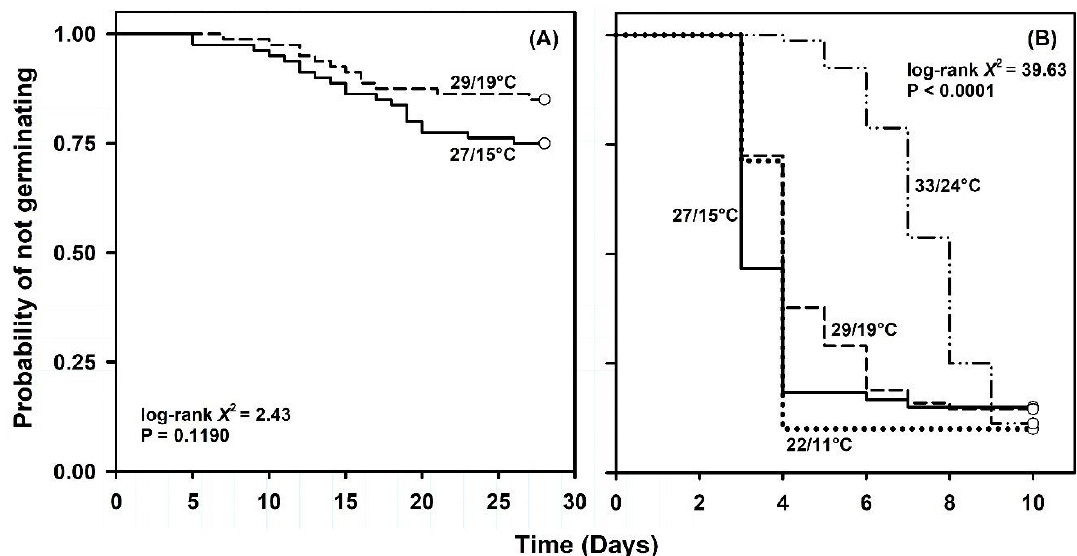
Figure 2. Kaplan–Meier estimates of survivor functions for Linum arenicola seeds exposed to ( A ) alternating temperatures that simulate the average maximum and minimum temperatures experienced throughout Florida during the winter (22/11 °C), early spring or late fall (27/15 °C), summer (33/24 °C), and early fall or late spring (29/19 °C) and ( B ) constant 22 °C after prior exposure to simulated seasonal temperatures. Pointwise 95% confidence intervals omitted for clarity.